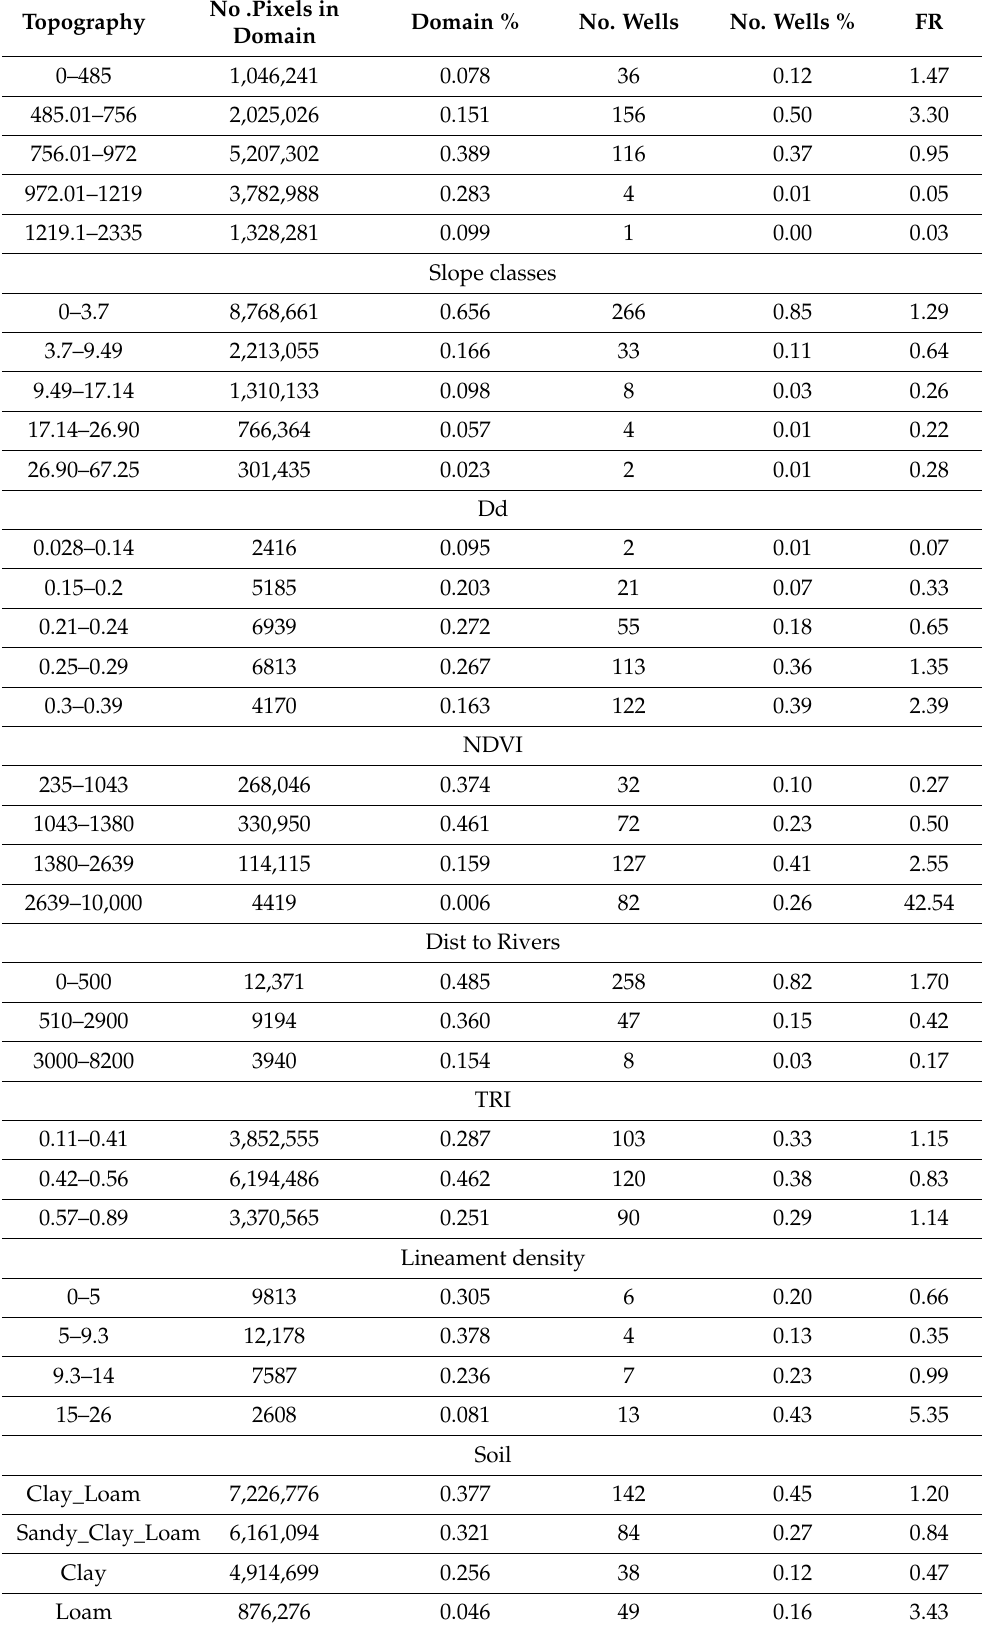
Table 1. Factors influencing groundwater occurrence and computed FR